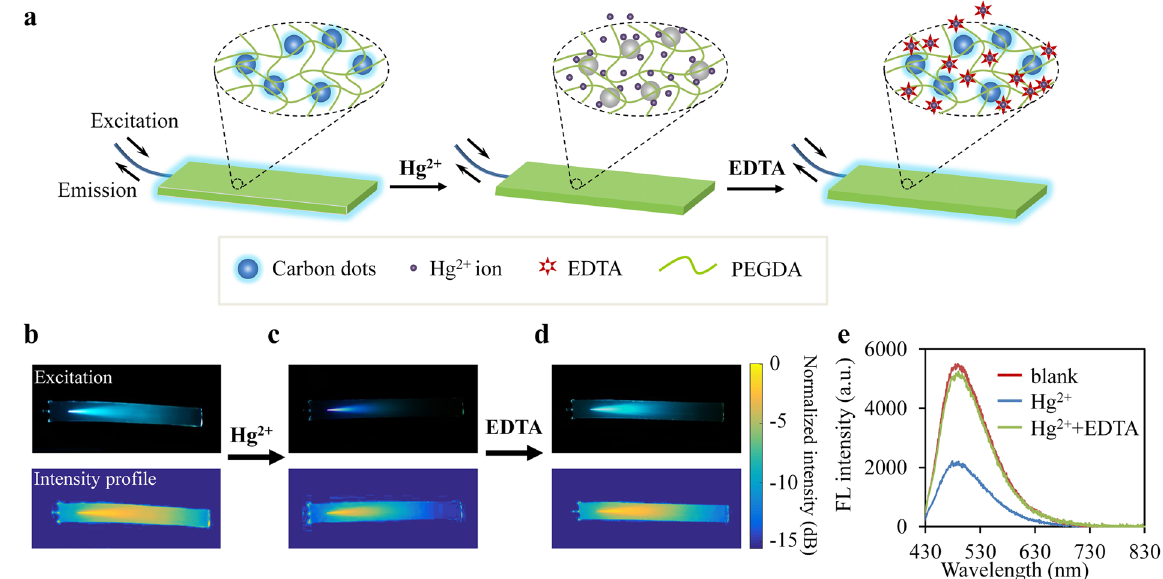
Figure 4. ( a ) Schematic illustration of fluorescence quenching in presence of Hg 2 + ions and fluorescence recovery with addition of EDTA. ( b – d ) Images showing reversible sensing of Hg 2 + . ( e ) Fluorescence spectra measured through the pigtailed